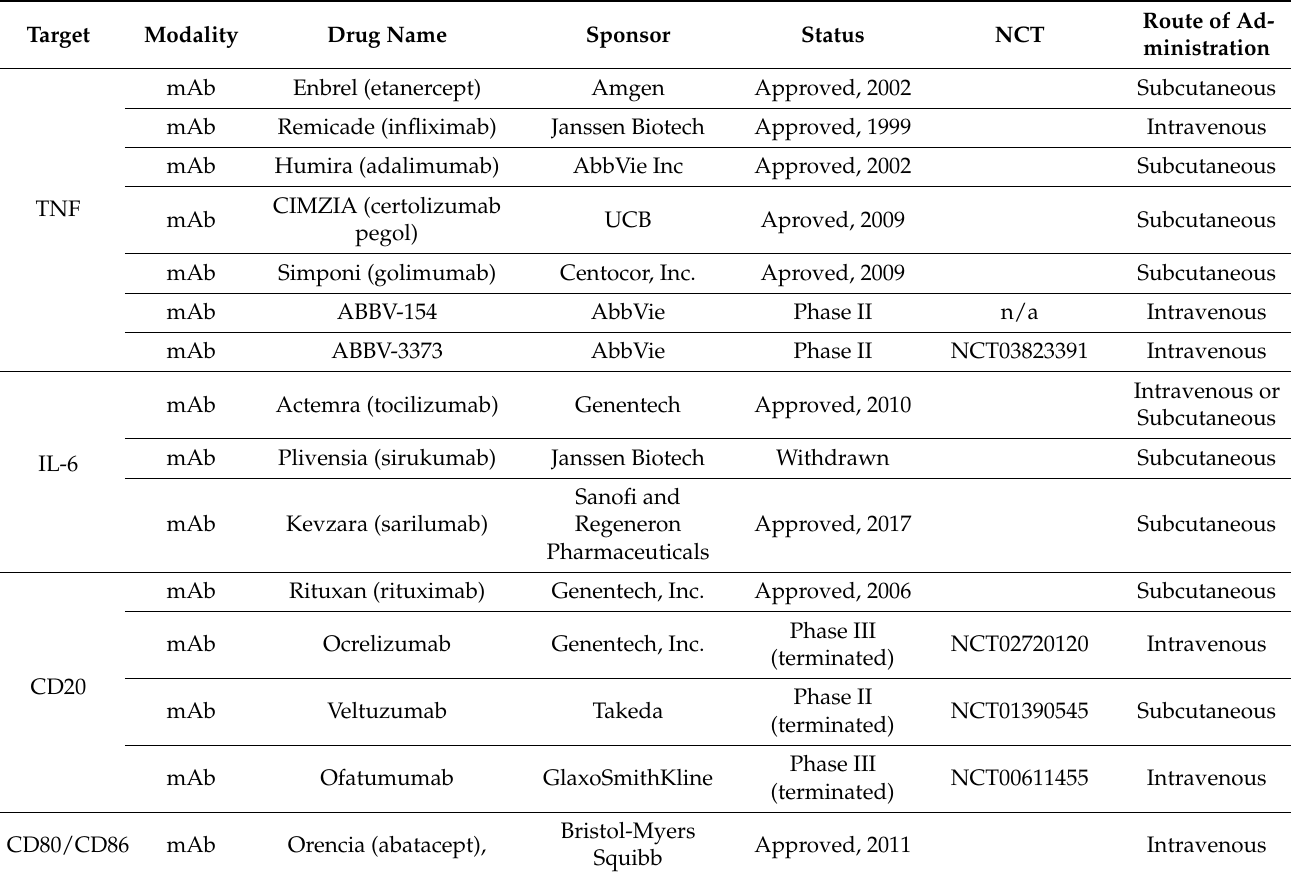
Table 5. Approved and investigational biologics and small molecules for